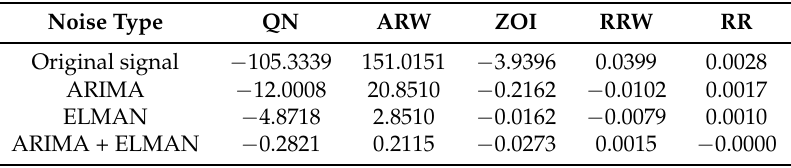
Table 1. Comparison results of coefficients before and after compensation. Here, QN indicates Quantization Noise, ARW indicates Angle Random Walk, ZOI indicates Zero Offset Instability, RRW indicates Rate Random Walk, and RR indicates Rate Ramp.